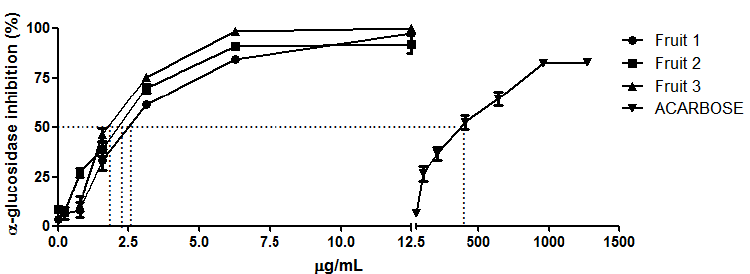
Figure 2. Concentration-dependent inhibition of α-glucosidase by baobab fruit pulp extracts and acarbose (standard).